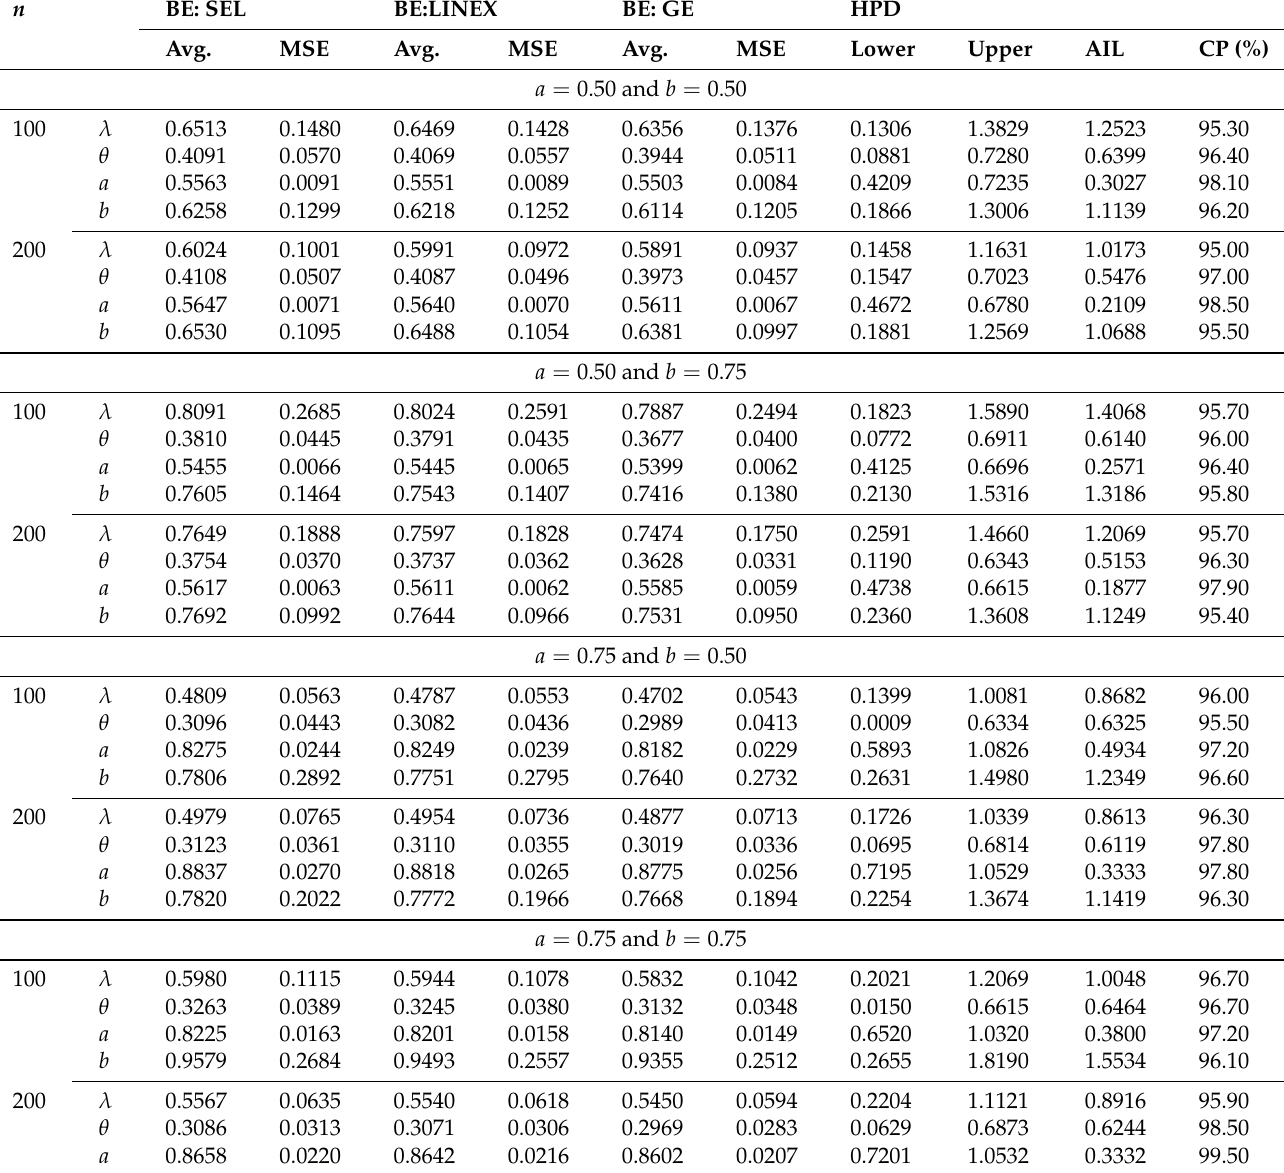
Table 9. Avg. estimated values and MSEs of the BE using MCMC for the BBE 2 distribution at different sample sizes n and different values of ( a , b ) when λ = 0.50, θ =